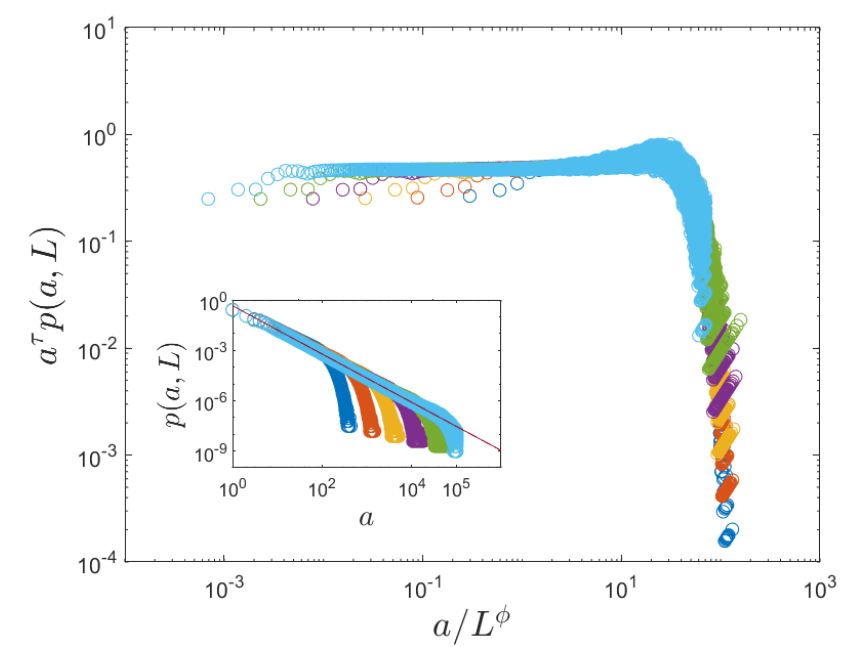
Figure 2. The plot of the scaling function of p ( a , L ) for various values of L = 32,64,128,256,512, and 1024 with δ = 0.25. The data are very well collapsed with τ = 1.44 and φ = 1.78. The inset shows the plot of p ( a , L ) for the same L as in the main panel and the straight guide line represents τ ≈